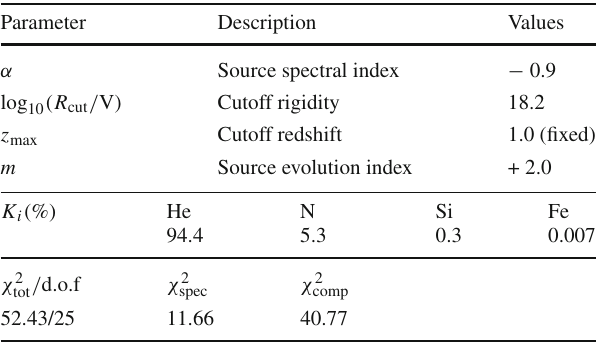
Table 3 UHECR best-fit parameter set for the one-population